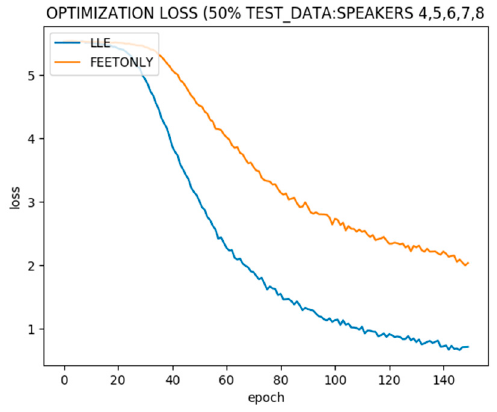
Figure 9. Training error vs. iterations with and without LLE (50% test and 50% training data).